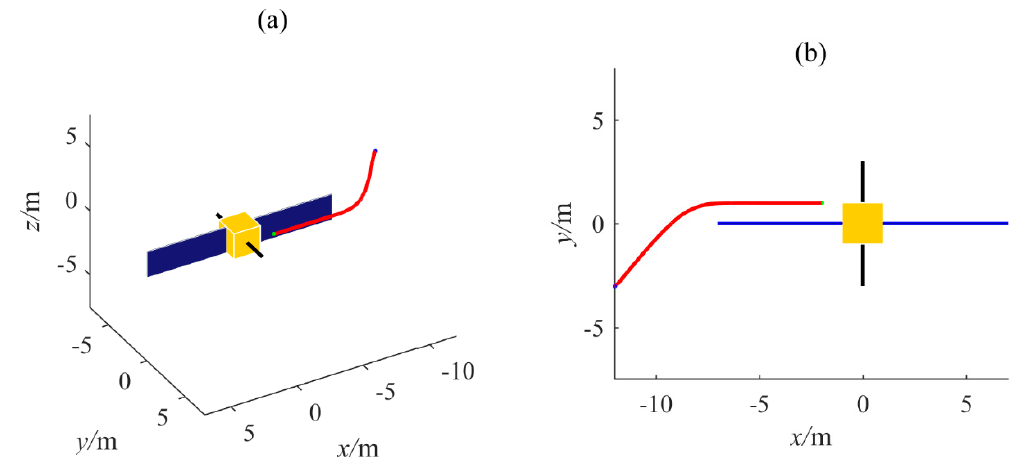
Figure 6. The proximity trajectory to target spacecraft. ( a ) The trajectory in 3D coordinates; ( b ) the projection of trajectory in the x-O-y plane.